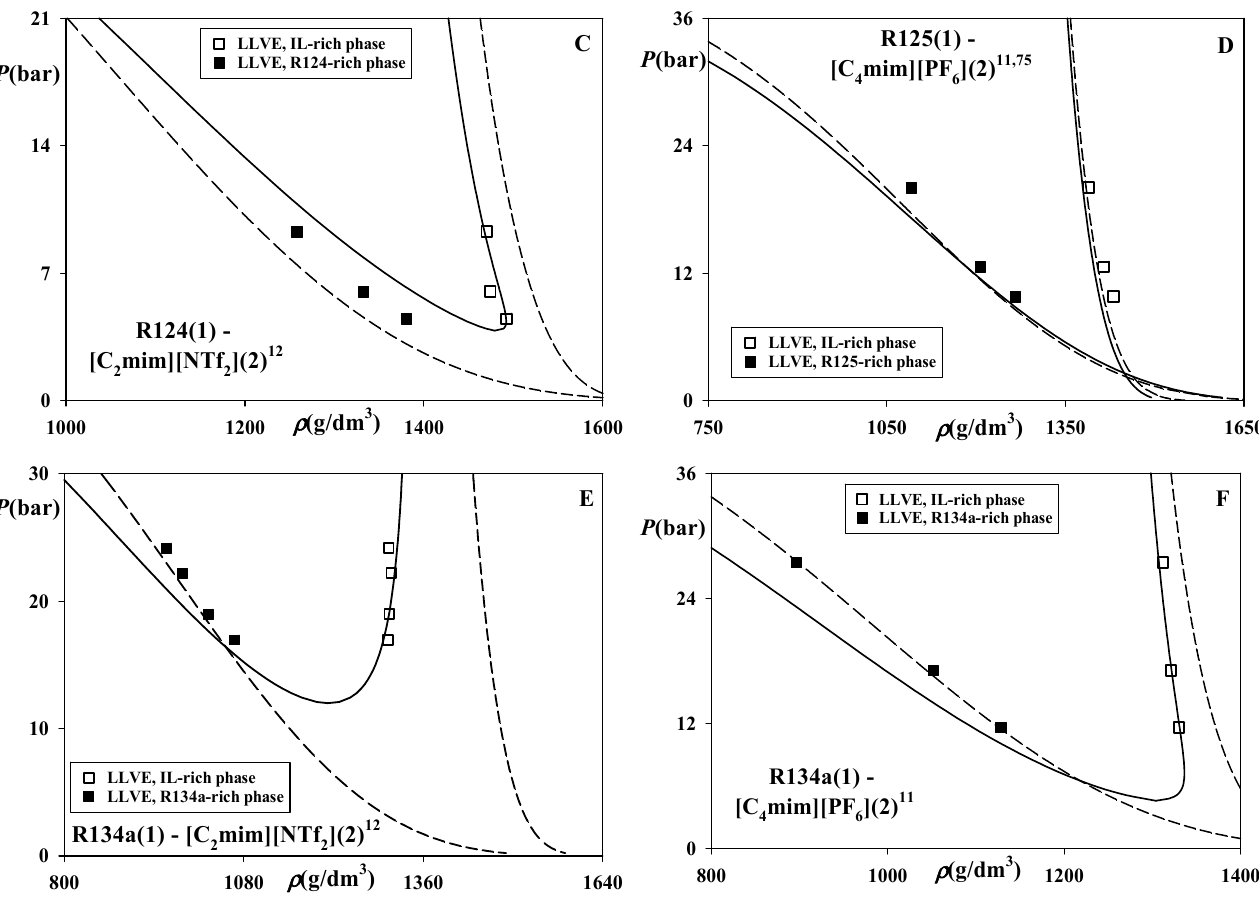
Figure 5. Densities of saturated liquid phases along LLVE in the systems of R114, R123, R124, R134a dissolved in [C 2 mim][NTf 2 ] and [C 4 mim][PF 6 ]. Points — experimental data [11,12,75,83]. Solid lines — predictions of CP-PC-SAFT, dashed lines — predictions of SAFT-VR-Mie. k 12 = 0 for both models.